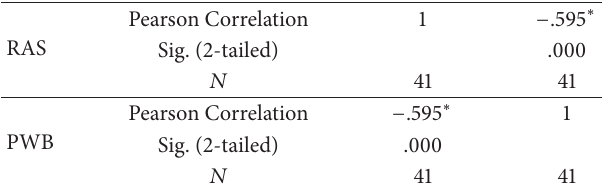
Table 3: Correlations between Recovery Assessment Scale (RAS) and Psychological Well-Being (PWB)